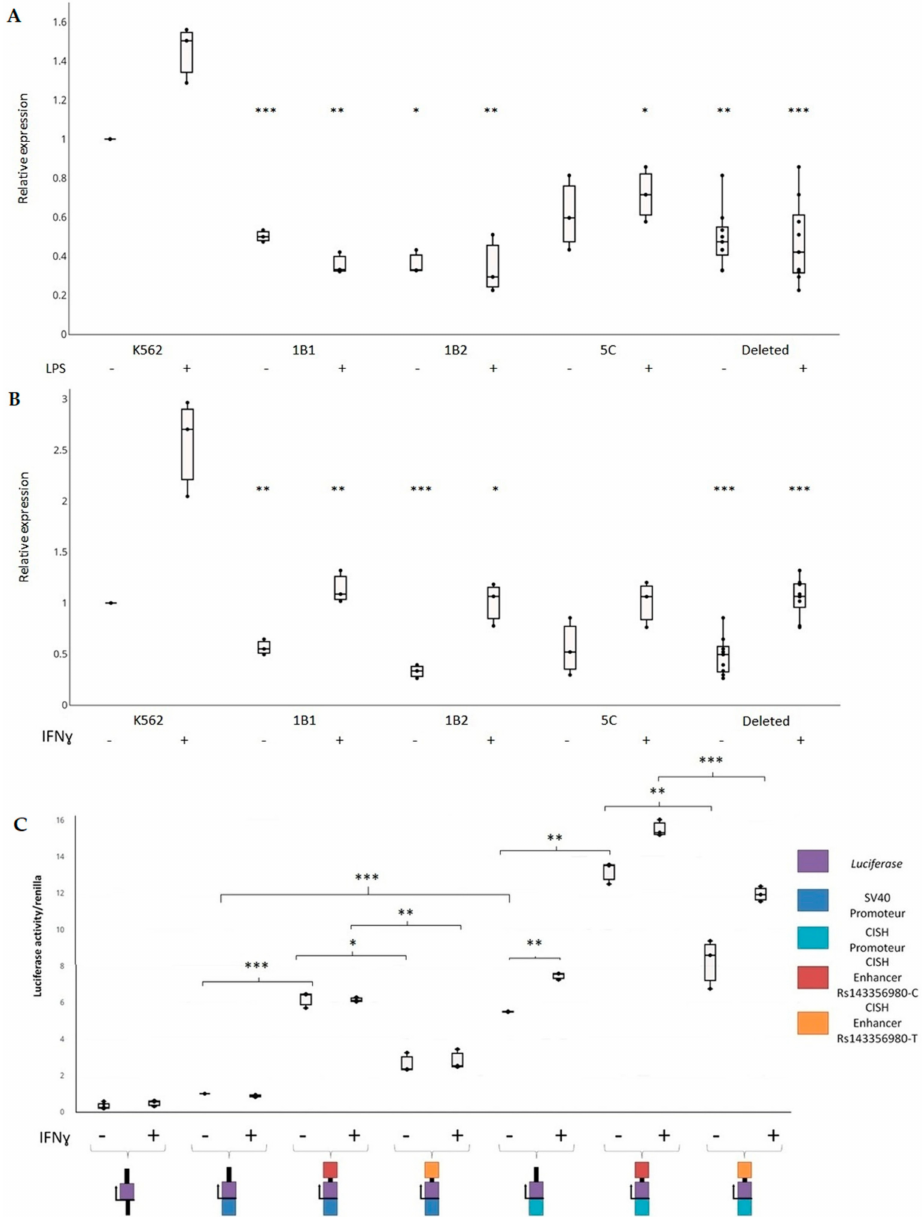
Figure 6. Enhancer effect of the genomic region containing rs143356980 on CISH expression. ( A ) CISH expression measurements in K562 cells and K562 − / − cells either unstimulated (-) or stimulated (+) with LPS. ( B ) CISH expression measurements in K562 cells and K562 − / − cells either unstimulated ( − ) or (+) with IFN γγ . For ( A , B ), three independent experiments with triplicates were performed, leading to nine measurements for each condition. The box plot of the mean of triplicates is shown for the three experiments. Mixed models that took into account the clustering of triplicates into the experiments were used to compare K562 cells to each K562 − / − clone. p values are shown for the comparison of the unstimulated K562 − / − clones with unstimulated K562 cells and for the comparison of the stimulated K562 − / − clones with stimulated K562 cells: *** for p < 0.001; ** for p < 0.01; * for p < 0.05. ( C ) Effect of rs143356980 on the enhancer activity. DNA sequences containing either rs143356980-C allele or rs143356980-T allele were cloned into a luciferase reporter that contained no promoter, a minimal promoter or CISH promoter. Three independent experiments with triplicates were performed in K562 cells unstimulated ( − ) or stimulated (+) with IFN γ , leading to nine measurements for each condition. The box plots show the mean of triplicates for three experiment. Mixed models that took into account the clustering of triplicates into the experiments were used to compare the luciferase activity of the constructs, with a special emphasis of the comparison of constructs containing rs143356980-C allele with those containing rs143356980-T allele. p values are shown for unstimulated cells and stimulated